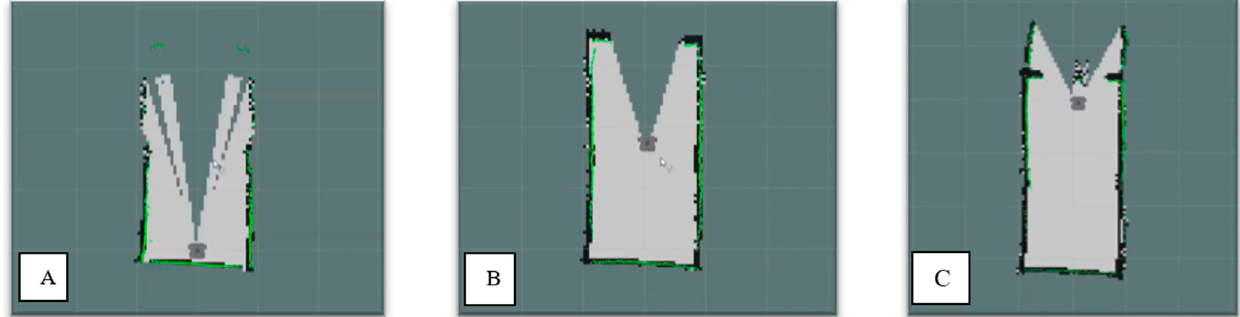
Figure 8. RViz map of test case 1 at positions ( A – C ) where the mobile robot travels toward a plane mirror.